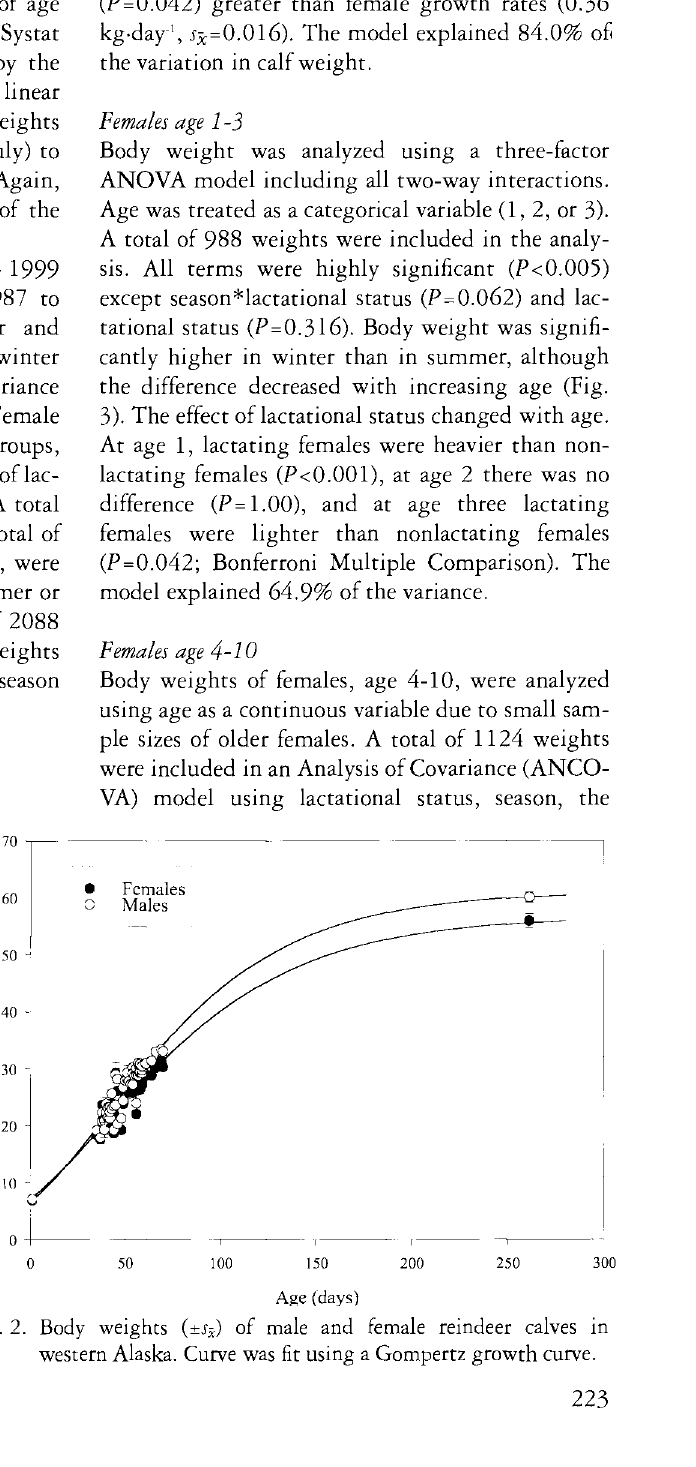
Age (days) Body weights (±3%) of male and female reindeer calves in western Alaska. Curve was fit using a Gompertz growth